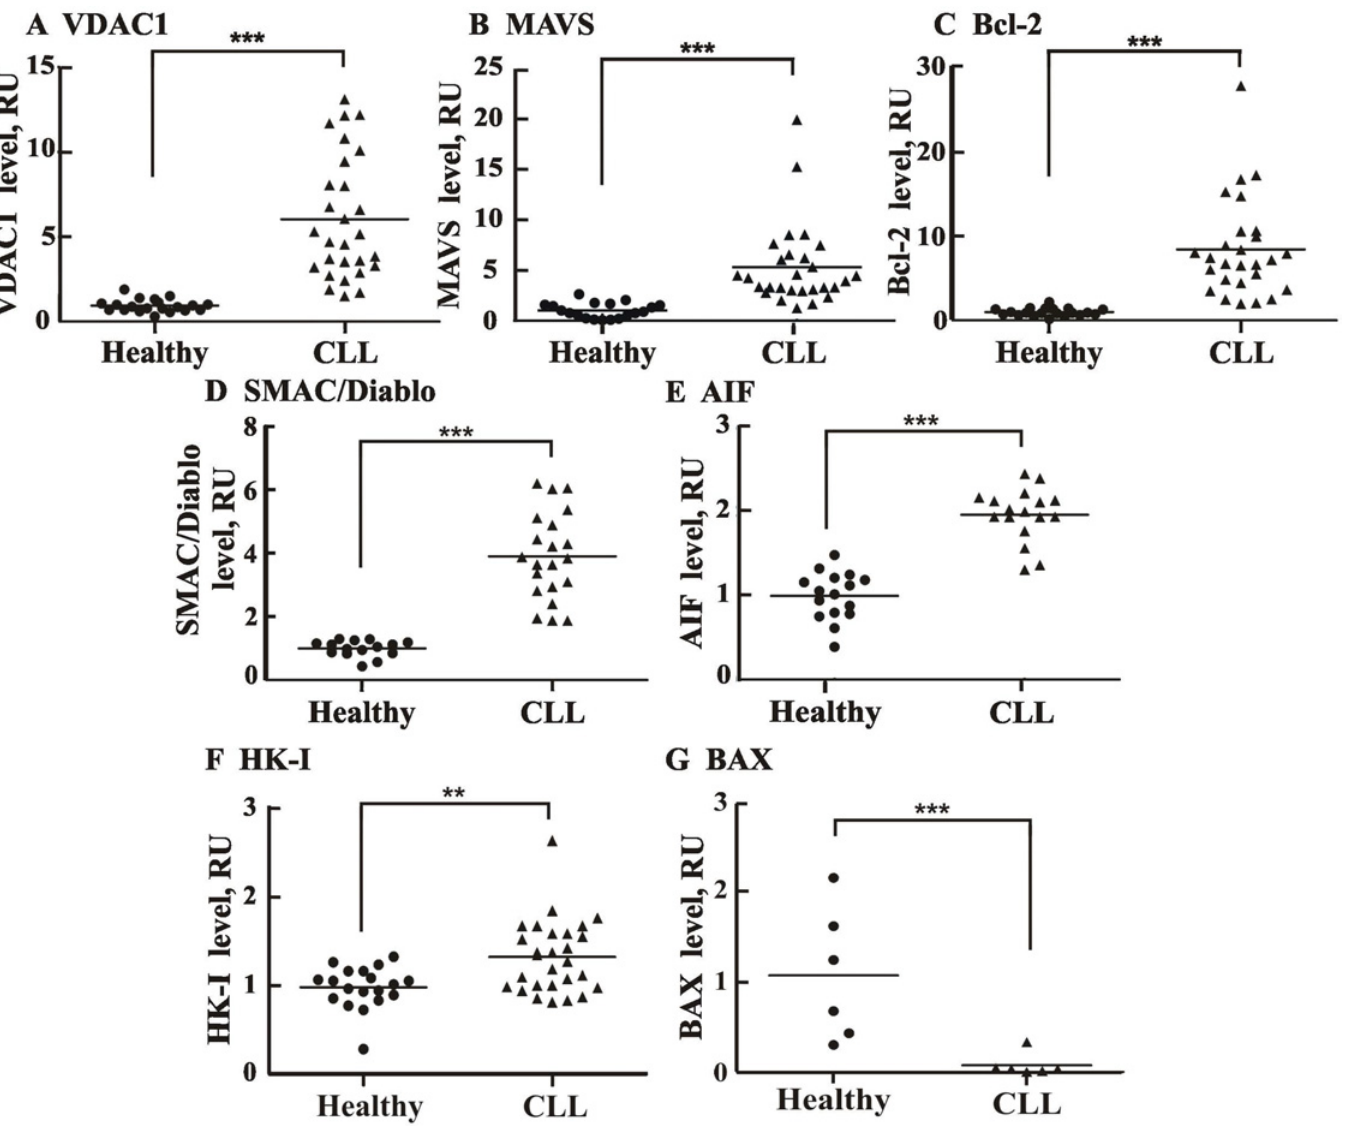
Fig 4. Comparison of apoptosis-related proteins in CLL patient- and healthy donor-derived PBMCs. Scatter plots display the expression levels of VDAC1 ( A ), MAVS ( B ), Bcl-2 ( C ), SMAC/Diablo ( D ), AIF ( E ), HK-I ( F ) and Bax ( G ), for each control subject and CLL patient, as analyzed in Fig 2. Statistics were calculated with GraphPad Prism software. Horizontal lines represent mean values for each group. A difference between the healthy donor and CLL patient groups was considered statistically significant when P < 0.001 ( *** ) or P < 0.01 ( ** ), as determined by the Mann-Whitney test.